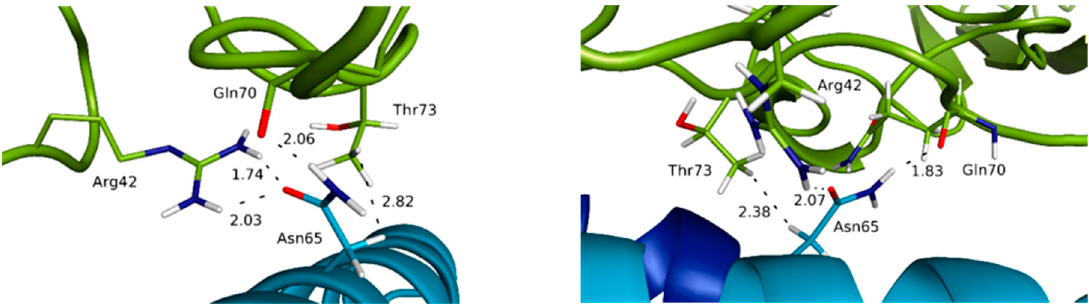
Figure 7. Representation of key interactions at the IL-15 / IL-2R β interface for the full system ( left ) and the trimeric system ( right ). The distances, indicated in Å, are represented by dotted lines.